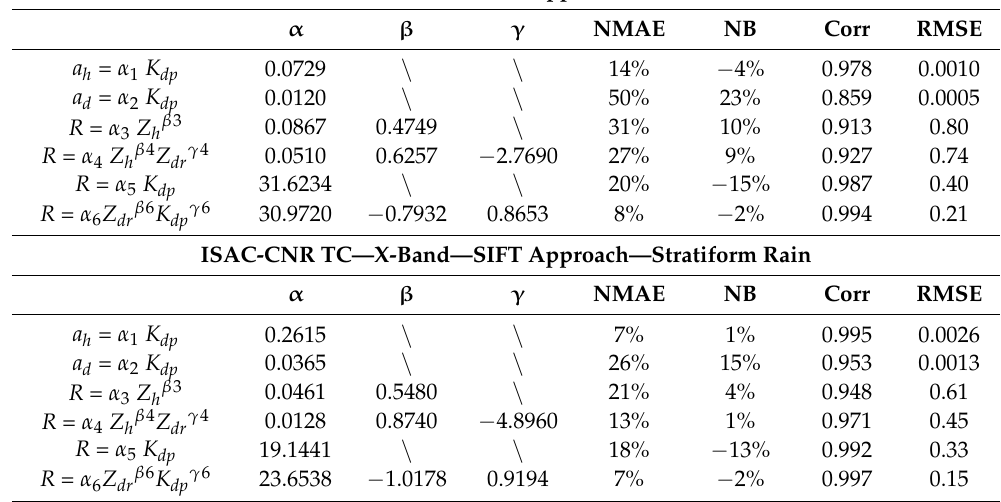
ISAC-CNR TC—C-Band—SIFT Approach—Stratiform